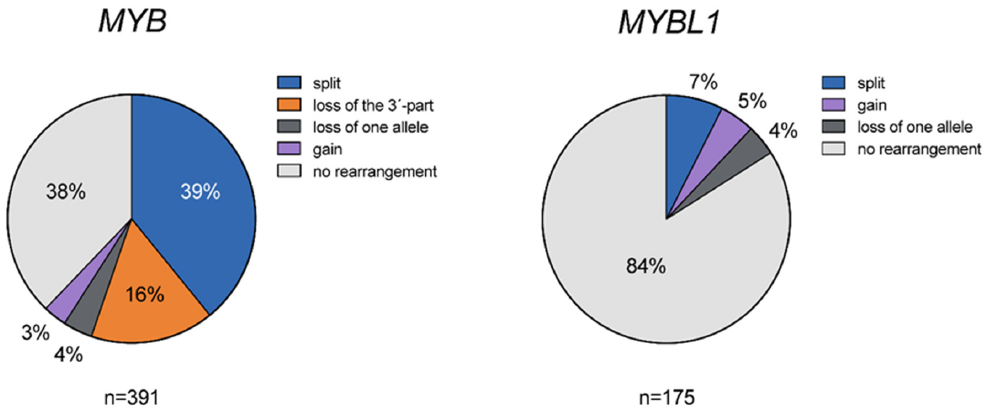
Figure 2. MYB and MYBL1 alterations in ACC. Pie charts showing the frequencies of different types of MYB and MYBL1 alterations detected by FISH in